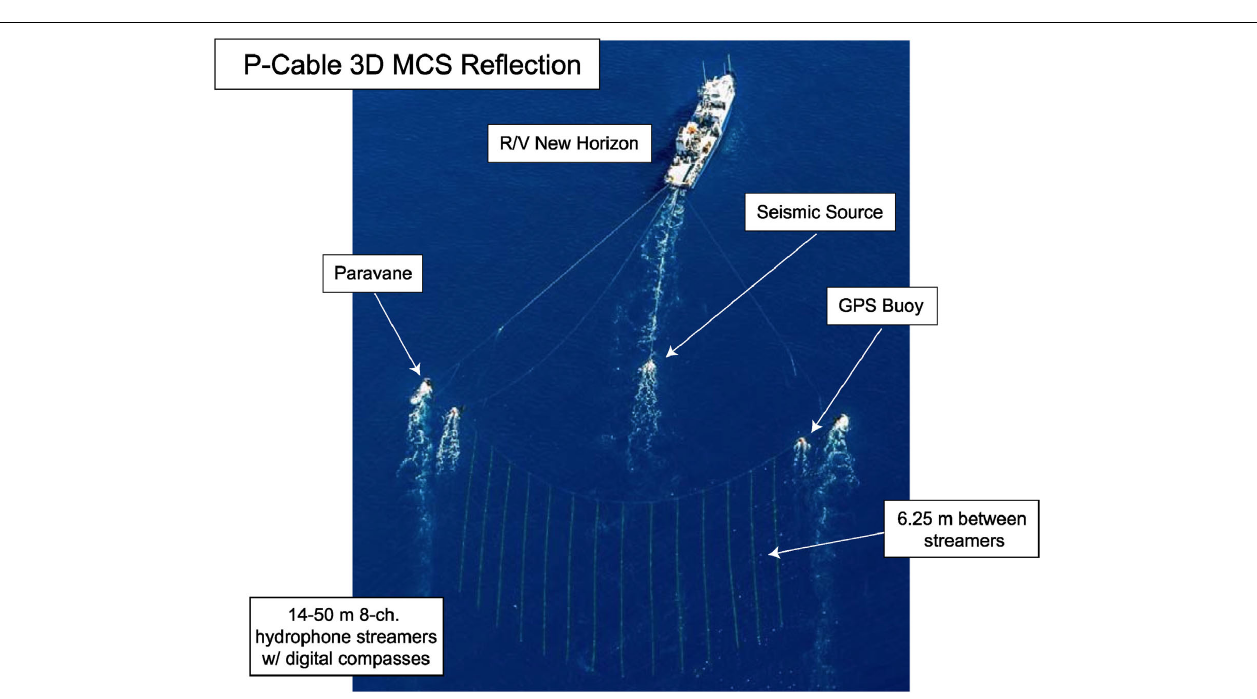
FIGURE 2 | Aerial photo of Scripps Institution of Oceanography’s Research Vessel New Horizon towing the P -Cable 3D Multichannel Seismic Reflection System, with major components of system labeled.